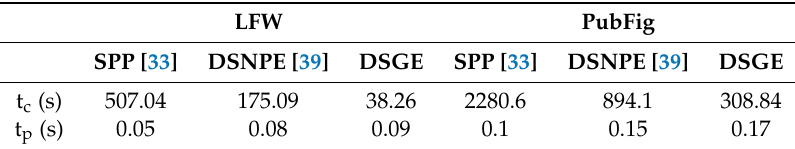
Table 9. The sparse adjacent graph construction time tc and the low-dimensional projection time tp of SPP, DSNPE and DSGE on the LFW and PubFig